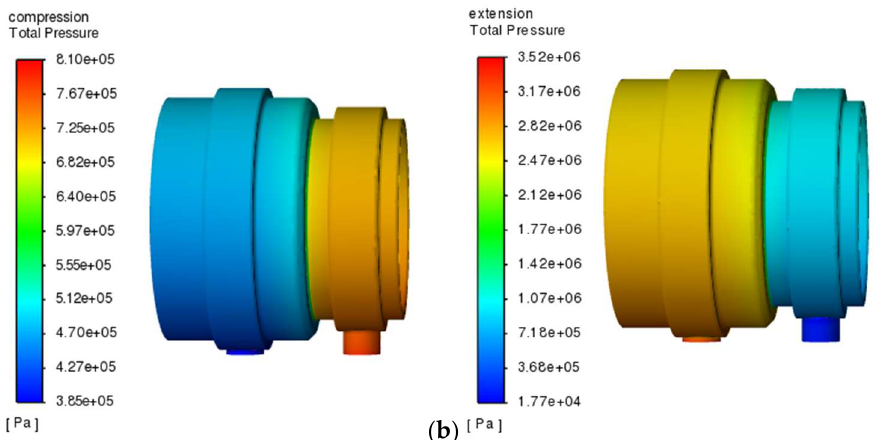
Figure 4. Numerical simulation results of oil flow through the PZV valve: ( a ) damper compression, ( b ) damper extension. ( b ) damper